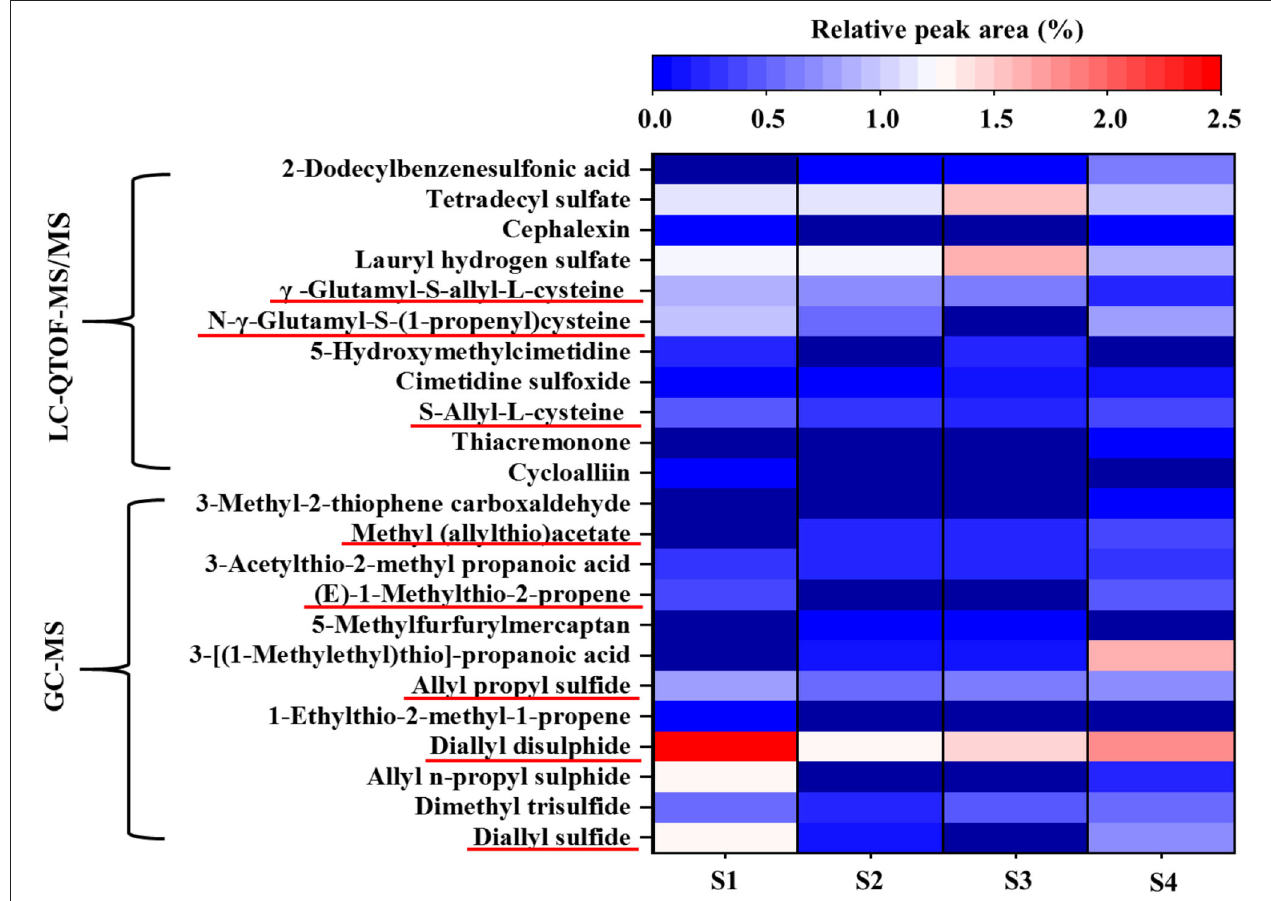
FIGURE 7 | Heat map of relative peak area changes in the main sulfides of different black garlic broth extracts based on GC-MS and liquid chromatography–quadrupole time-of-flight–tandem mass spectrometry (LC–Q-TOF–MS/MS) analyses. The colors from blue to red indicate that the sulfide content gradually increased; dark blue indicates that sulfide was not